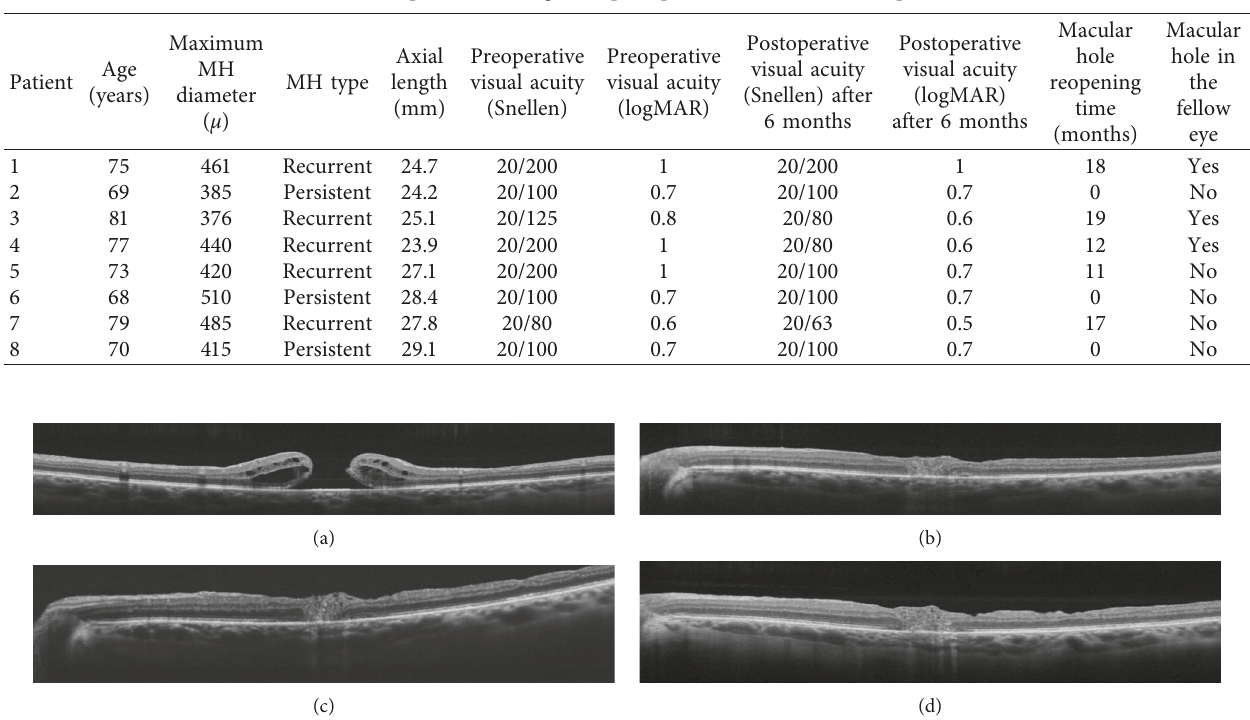
Table 1: Preoperative findings and postoperative outcomes of the